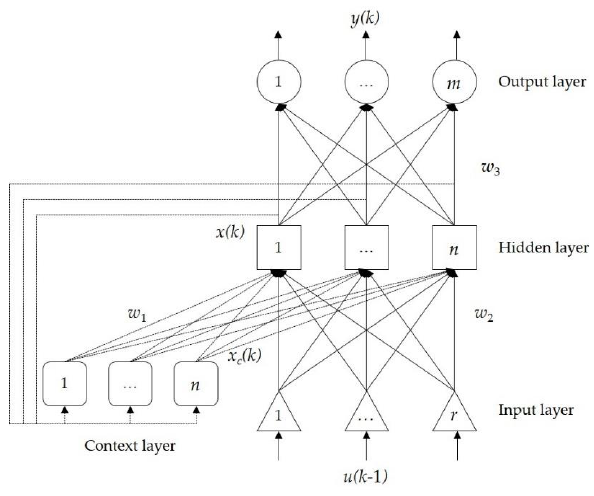
Figure 4. Structure of the Elman neural network (ENN).